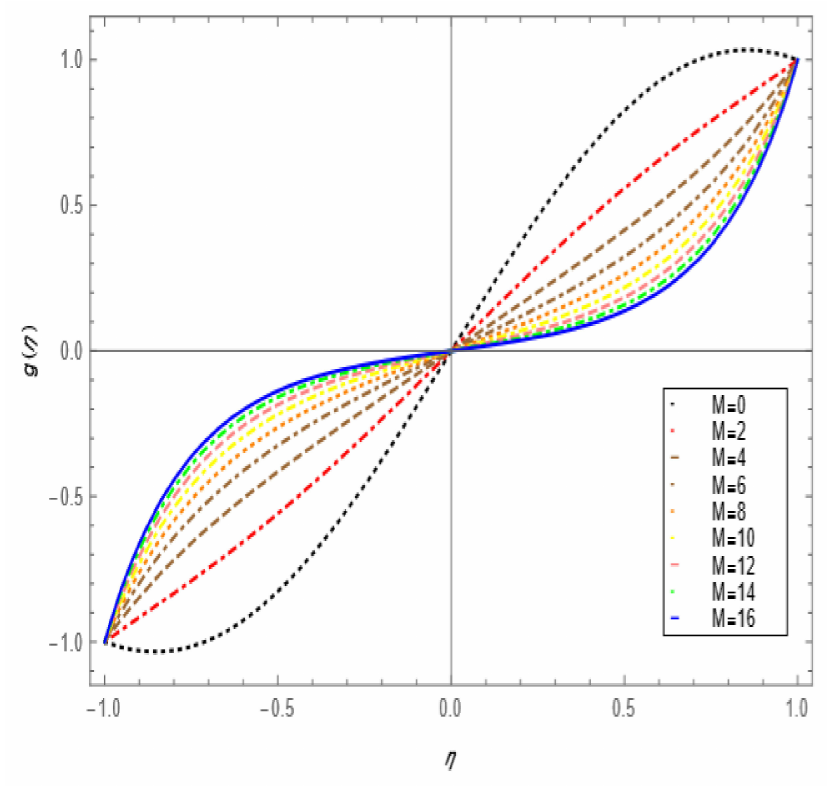
Figure 4. Tangential velocity profile effect for magnetic parameter for = 1, Re = 1, ϕ 1 = ϕ 2 = 0.01, Ec = 0.00068, Pr =